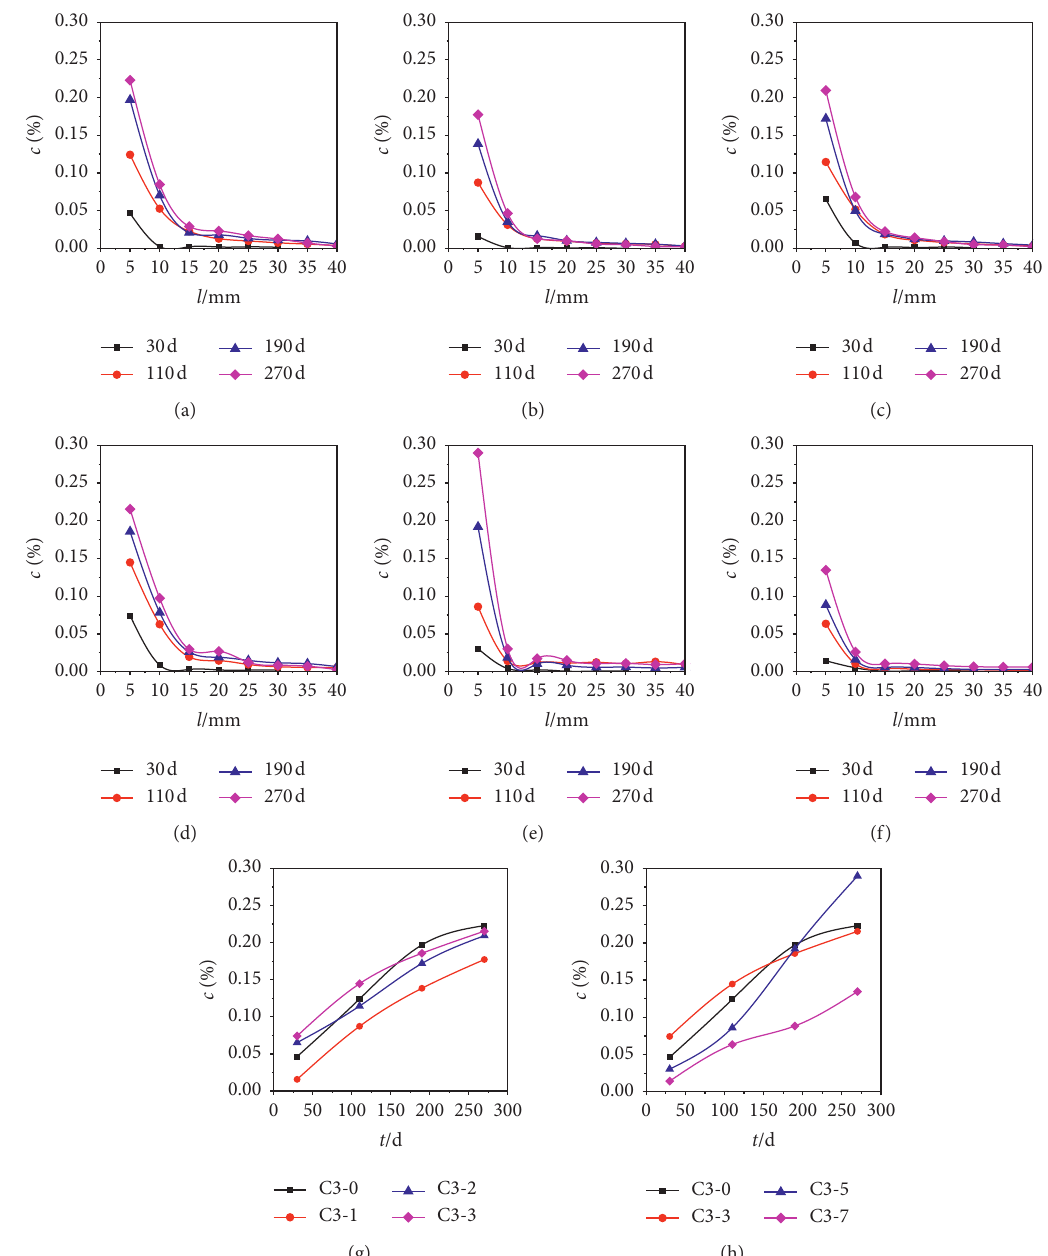
Figure 2: Variation of chloride ion concentration with depth (a–f) and corrosion time (g, h) under the single corrosion